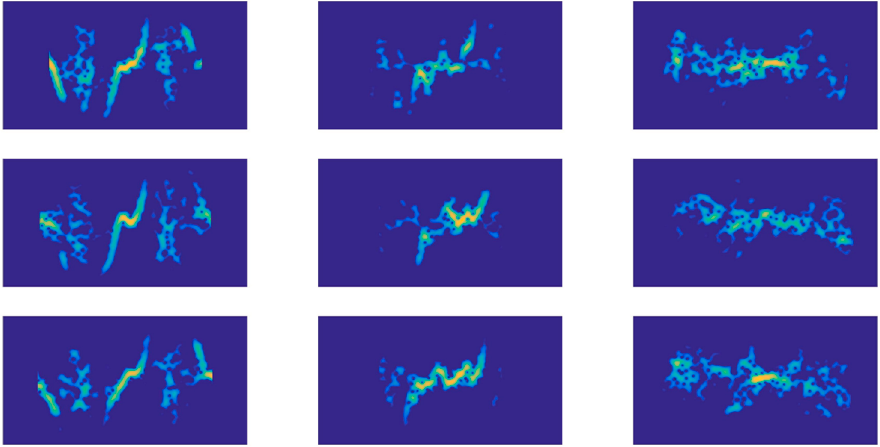
Figure 9. Doppler signatures of three hand gestures for three samples. Three pictures in each column represent G1, G2 and G3, respectively.